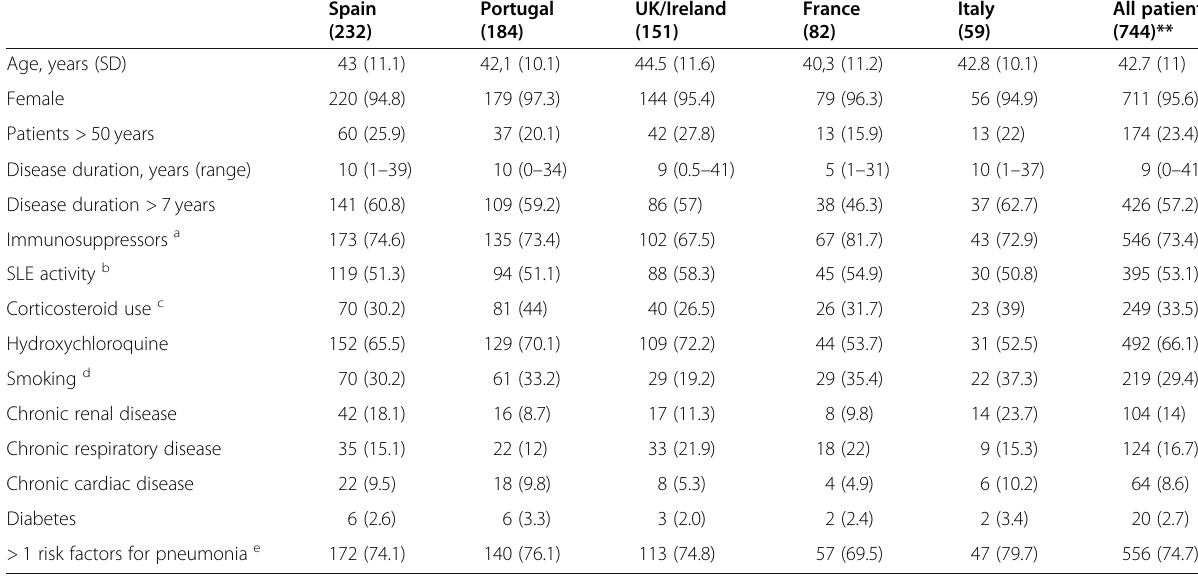
Table 3 Demographics, risk factors for pneumonia, and SLE-specific data of European patients * Spain